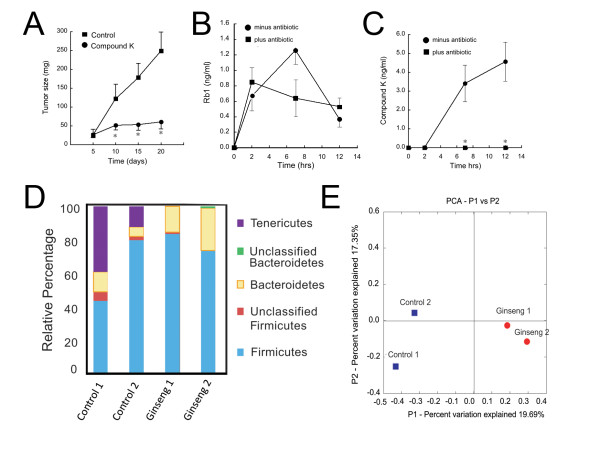
Dietary ginseng alters the composition of the bacterial flora while intraperitoneal compound K inhibits colon cancer xenograft growth. A. Compound K inhibits colon cancer growth in tumor xenograft. HCT116 cells (5*10^6 cells) were implanted into flanks of nu/nu mice and allowed to grow for 5 days. Mice were then treated with compound K (30 mg/kg-body wt or DMSO (compound K vehicle). At indicated times tumor size was estimated by linear dimensions [volume = 1/2 × length × (width)2] and expressed in mg (*p < 0.05 compared to control, n = 5 mice in each group). B. Rb1 absorption. Mice were un-treated or treated with metronidazole in the drinking water. After 5 days animals were gavaged with 500 mg ginseng extract/kg body wt. At indicated times after ginseng gavage, plasma levels of ginsenoside Rb1 were measured by UPLC-mass-spectrometry/TOF. C. Compound K absorption. Mice were treated as described in 4B and Compound K (C-K) measured by UPLC-mass-spectrometry/TOF. Data were expressed as means ± SEM depicted by vertical bars (p < 0.05 compared to mice not receiving antibiotics). Note that metronidazole suppressed serum compound K but not Rb1 levels. D. Effects of ginseng on bacterial phyla. Mice were fed Western diet or Western diet containing 250-ppm ginseng. After 2 wks feces were collected and bacterial DNA extracted. Using 16S rRNA gene libraries, bacteria were classified by phyla as described in "Materials and Methods". E. Principal coordinate analysis (PCA) of bacterial distributions. Note that ginseng decreased the abundance of Tenericutes phylum and appeared to widely separate species as assessed by PCA.